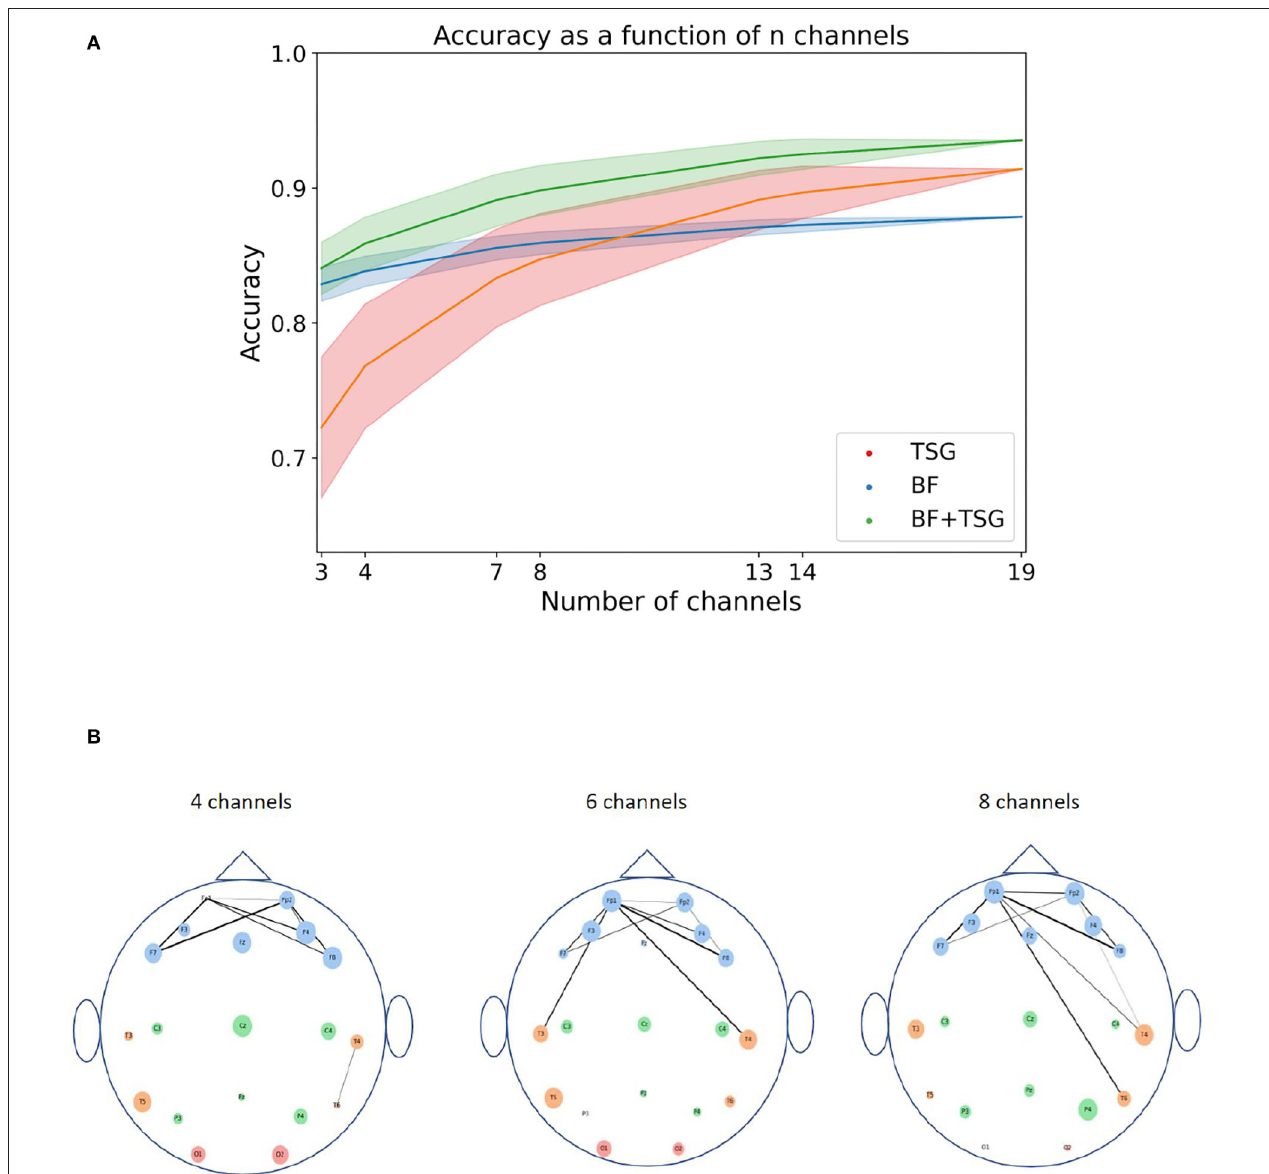
FIGURE 5 | Sensor and pair of sensors analysis. The top figure shows the distribution of averages for varying numbers of channels for TSG, BF, and TSG+BF. The bottom figure shows the importance of each sensor and pair of sensors: the size of the circles for each channel is proportional to its rank amongst channels; the line width of the edge between two channels is proportional to the pair’s rank amongst pairs of channels; the color of the channel is indicative of the region of the head (frontal, temporal, central, occiptal). (A) Combinatorial search over sensor configurations with corresponding accuracies. Shaded regions contain 90% of the accuracies for a given number of subsets. (B) Channel importance (size of channel) for every channel and channel pair importance (line width of connection) for top subset of all pairs. We do not show all edges so as not to crowd the figure.